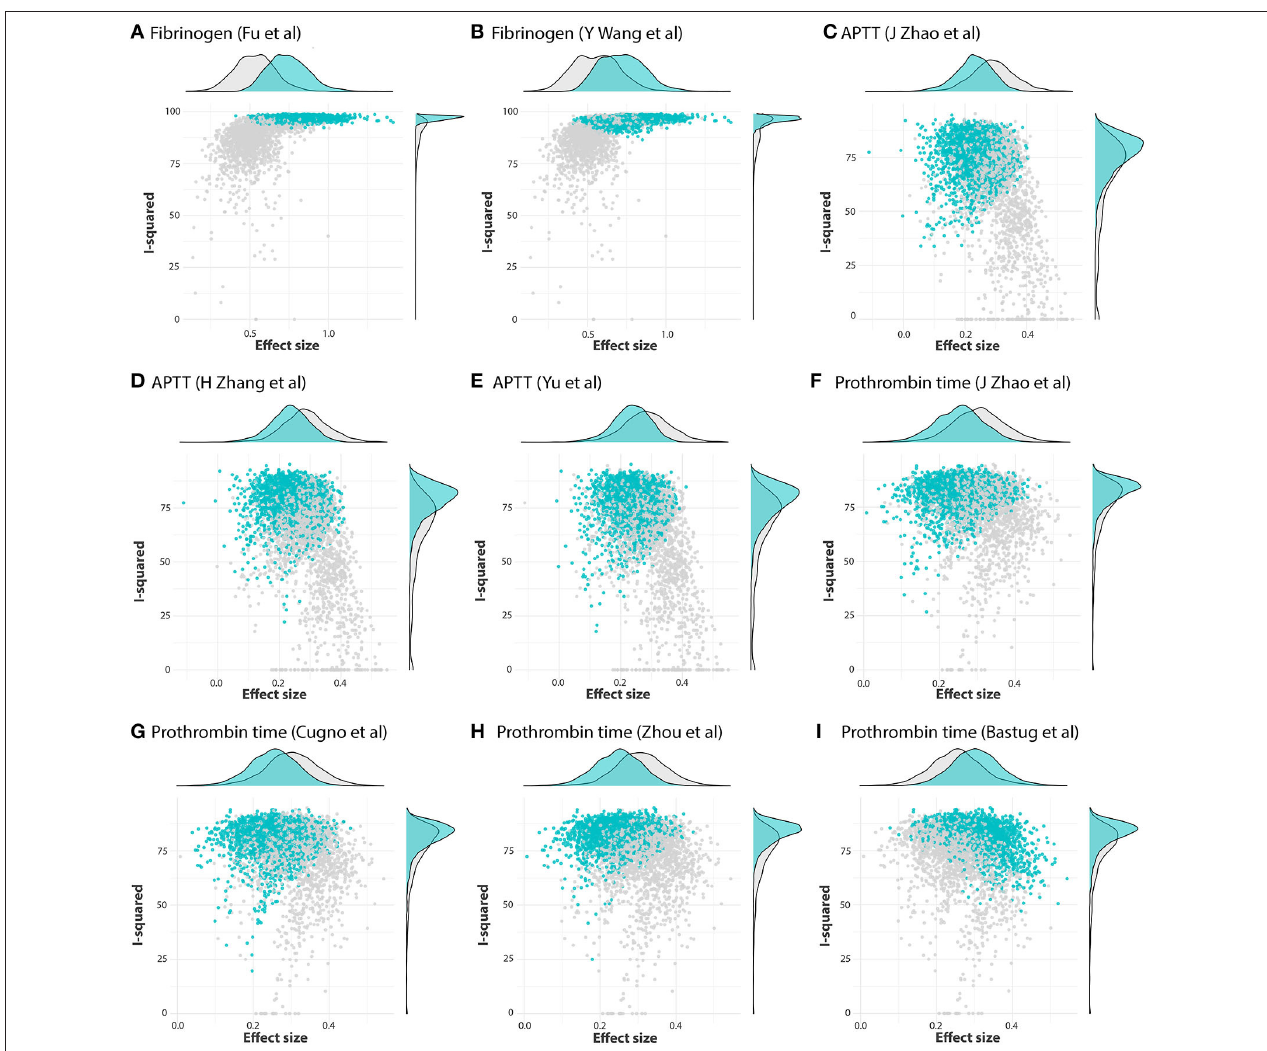
FIGURE 6 | GOSH plots fixed for influential studies in meta-analysis models. (A,B) FIB, (C–E) APTT, and (F-I)